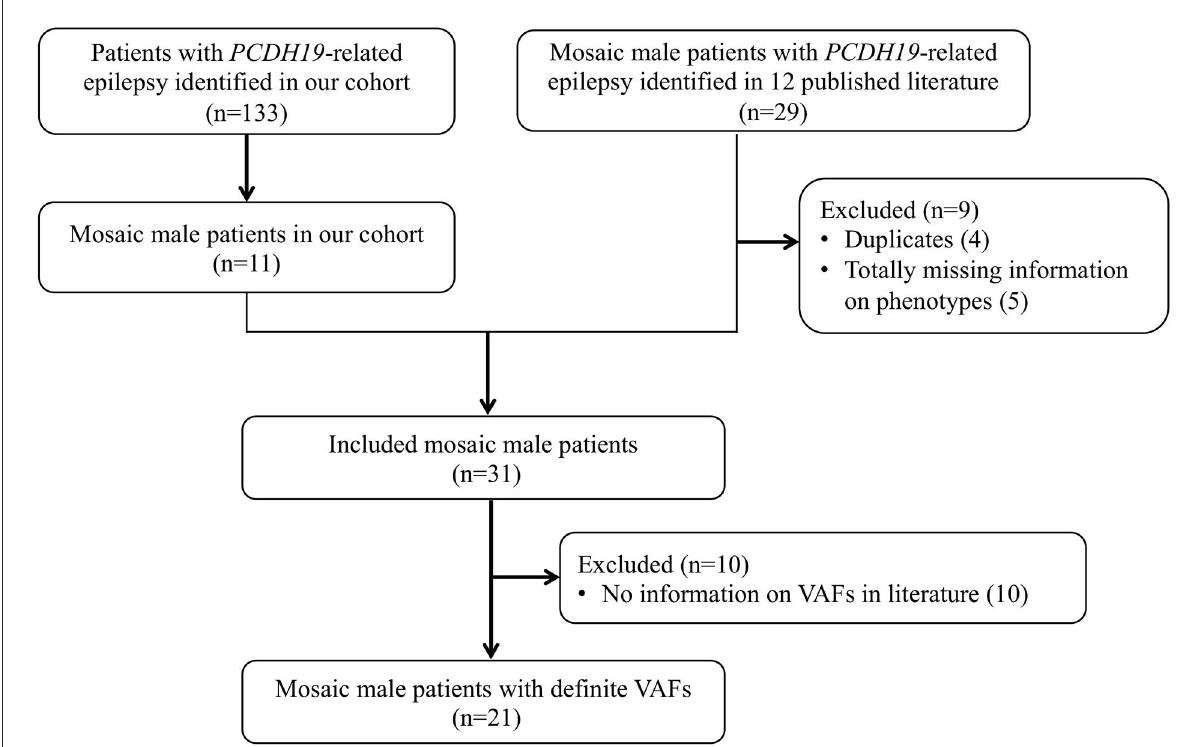
FIGURE1 Flowchart of study sample inclusion and exclusion. A total of 31 patients were included from our cohort ( n = 11) and the literature ( n = 20) in the genotypic and phenotypic analysis. For further analysis of VAF and phenotype correlation, excluding not providing specific VAF in 10 patients, 21 patients were